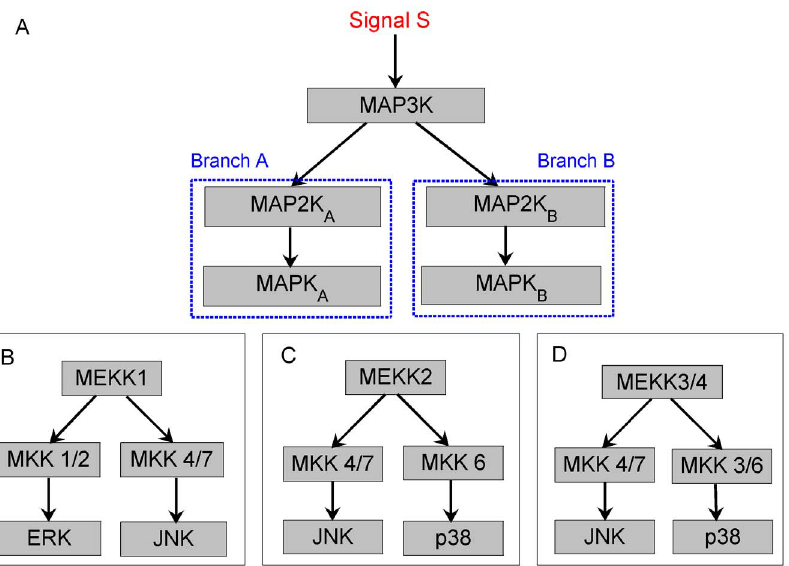
Figure 2. The branched MAPK cascade network motif. (A) A schematic diagram representing a simple branched cascade with two parallel pathways that is seen in many experimental systems, e.g., the T-cell receptor network [8]. The initial signal S activates a common MAP3K that can phosphorylate two different types of MAP2K molecules, viz., MAP2K A and MAP2K B . Each MAP2K type activates a particular type of MAP kinase, MAPK A and MAPK B , respectively. Specific examples of branched MAPK cascade motifs obtained from the experimental literature are shown in (B–D). They correspond to systems with the specific MAP3K (the branching point of the motif) being (B) MEKK1 that activates both MKK1/2 [15] and MKK4/7 [16,17], (C) MEKK2 that activates both MKK4/7 [18,19] and MKK6 [19], and (D) MEKK3/4 that activates both MKK4/7 [18–22] and MKK3/6 [19–21].